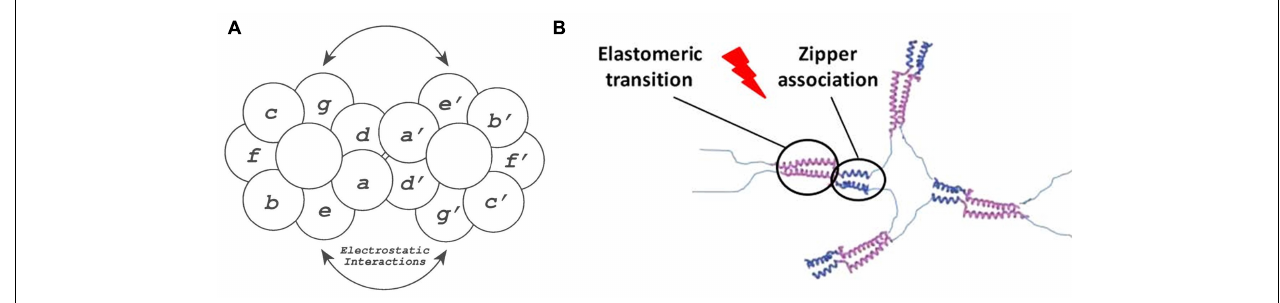
FIGURE 6 | (A) Schematic representation of the zipper dimerization interface, where the 7 amino acids forming the alpha-helical turns are represented with letters. Herein a and d (cid:48) amino acids form the hydrophobic interactions, whereas e and g (cid:48) amino acids form the electrostatic interactions reproduced with permission from (doi: 10.1101/gad.7.6.1047), copyright 1993. (B) Schematic representation of the elastin-like phase transition, represented in purple, and the dimerization of leucine zipper domains, represented in blue, in the formation of a ELR hydrogel reproduced with permission from (doi: 10.1021/acs.biomac.5b01103), copyright